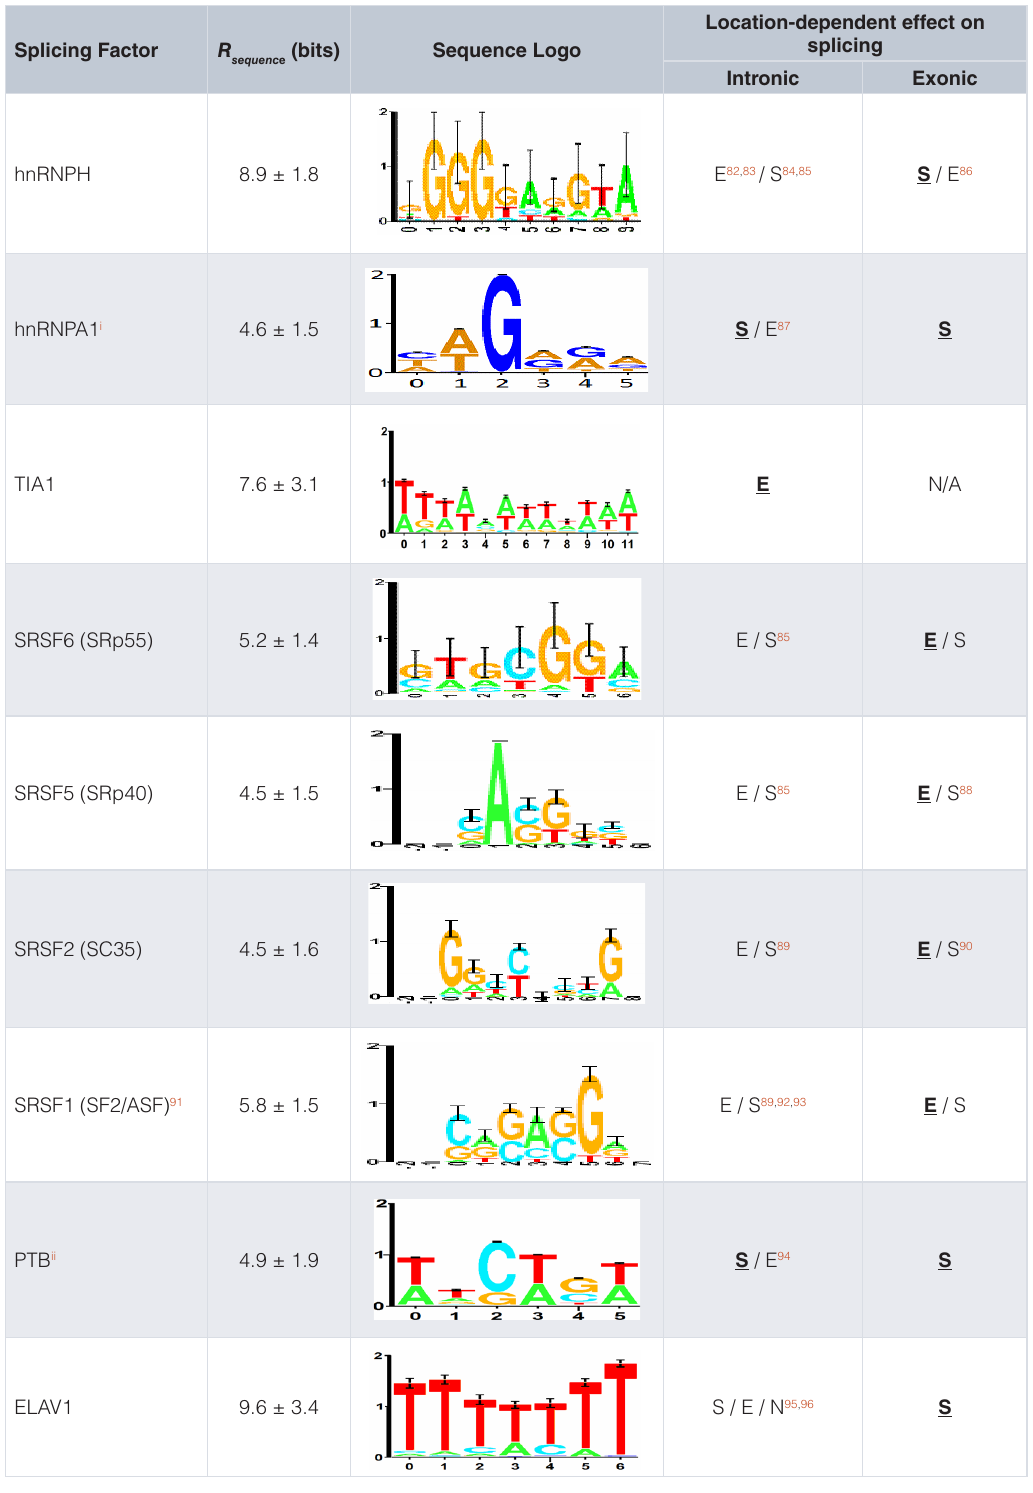
Table 1. Splicing regulatory protein binding sites ASSEDA scans for and their associated effect on